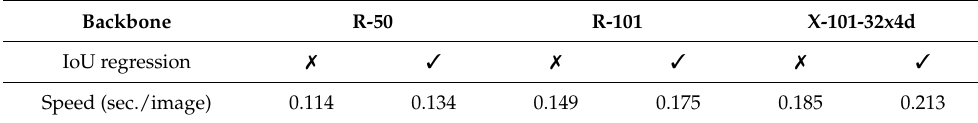
Table 4. Inference speed of different backbones on a single TITAN X GPU. Backbone